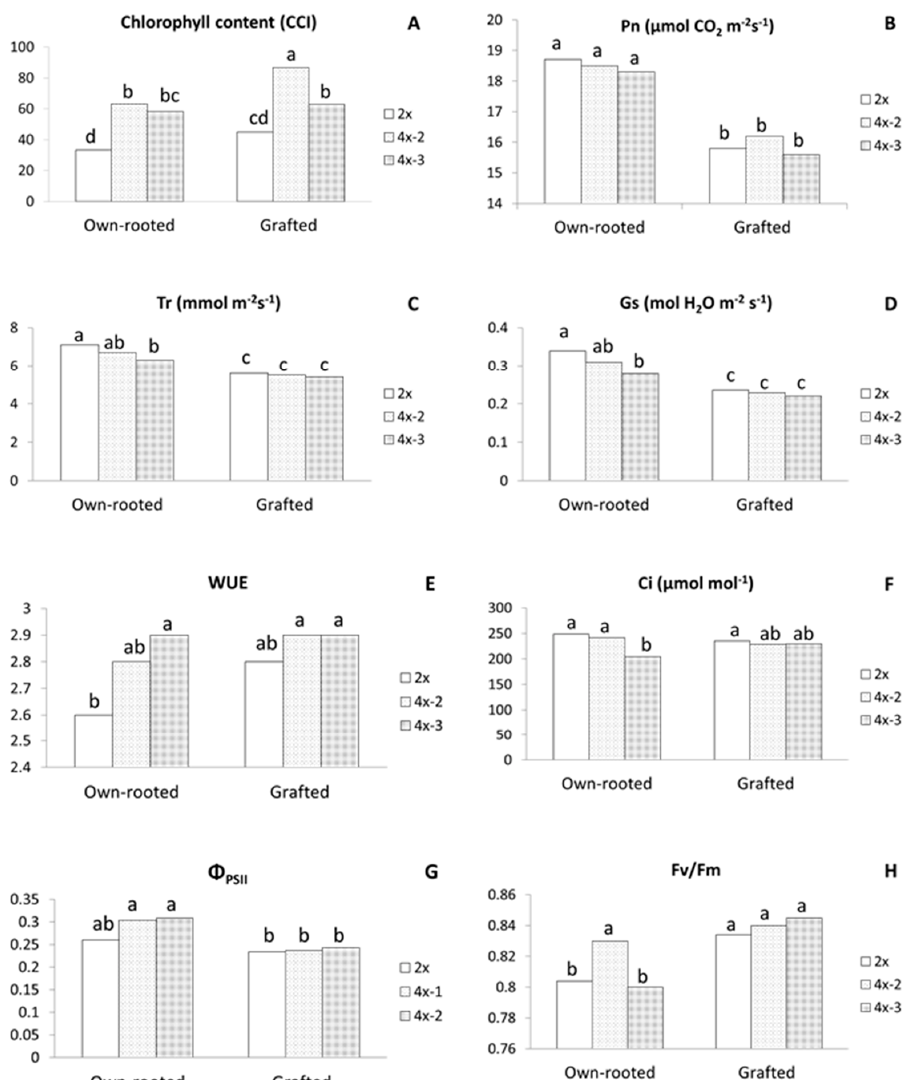
Figure 4. Physiological parameters of the ‘Free Redstar’ apple diploid and its tetraploid clones evaluated for the own-rooted and M9-grafted three-year old trees growing in the Research Institute of Horticulture (Skierniewice, Poland) (RIH) experimental orchard; ( A ) chlorophyll content index (CCI), ( B ) net photosynthetic rate (Pn), ( C ) transpiration rate (Tr), ( D ) stomatal conductance (Gs), ( E ) water-use efficiency (WUE), ( F ) and internal CO 2 concentration (Ci), ( G ) photosynthetic quantum yield ( Φ PSII ), and ( H ) quantum efficiency of open photosystem II centres (Fv/Fm); means for each trait marked with the same letter do not differ significantly at p = 0.05; Duncan’s test.